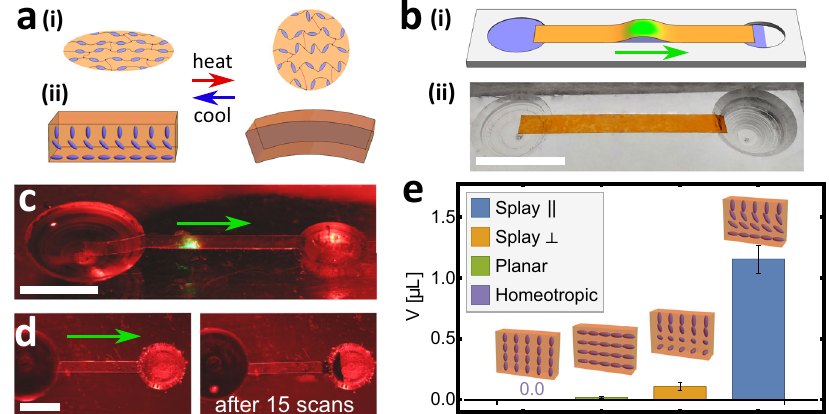
Fig. 1 | The design and demonstration of an LCG photo-peristaltic pump. a (i) SchematicsofanLCEshowingcontractionalongthedirectionofthealignment.(ii) Bending of an LCG sheet with splay-bend director caused by the bottom side contracting and the top side expanding on heating. b (i) Schematic picture of the experimental system with the arrow denoting the scanning and fl uid transport direction, and (ii) a picture of an unstimulated system. c Photograph of the